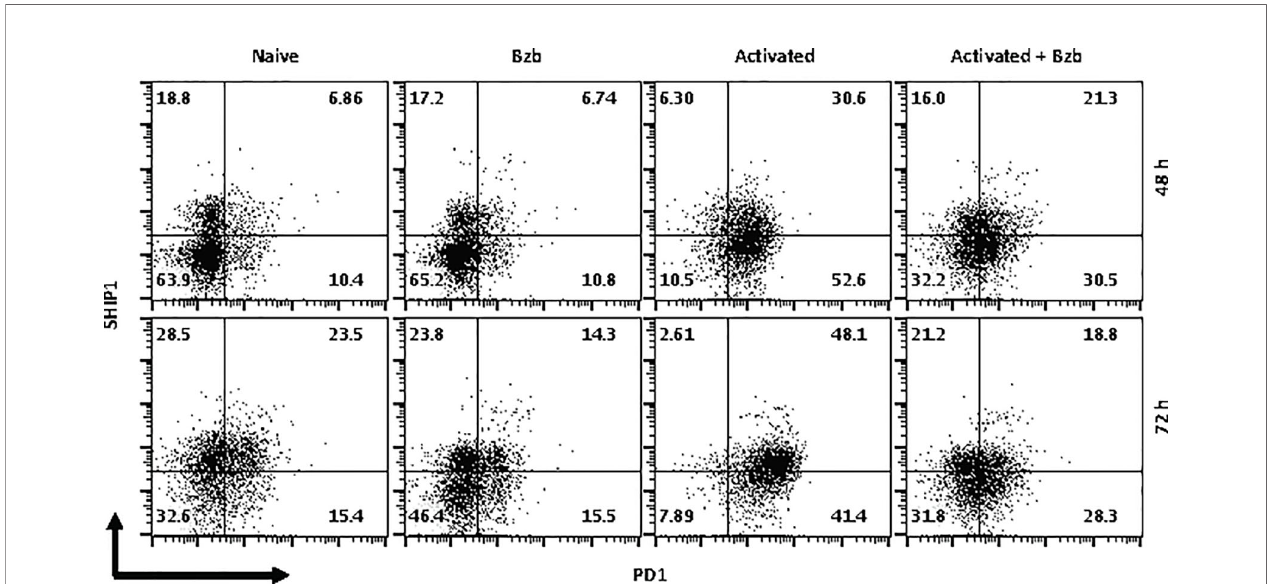
FIGURE 10 | Bortezomib treatment decreases the expression of exhaustion molecule PD1 in activated CD8 + T cells. CD8 + T cells were puri fi ed from the spleen and lymph nodes of naïve BALB/c wild-type (WT) mice. Cells were stimulated in vitro with soluble anti-mouse CD3 and CD28 antibodies (1 µg/ml each) for ~20 h followed by treatment with 10 nM bortezomib. Surface staining for CD8 and PD-1 as well as intracellular staining for SH-2 containing inositol 5 ’ -polyphosphatase 1 (SHIP1) was performed after 48 and 72 h post T cell activation. Representative dot plots depict the frequencies of gated CD8 + T cell populations expressing SHIP1 and PD-1 in the following groups: naïve CD8 + T cells treated with saline, naïve CD8 + T cells treated with bortezomib (Bzb), activated CD8 + T cells treated with saline and activated CD8 + T cells treated with